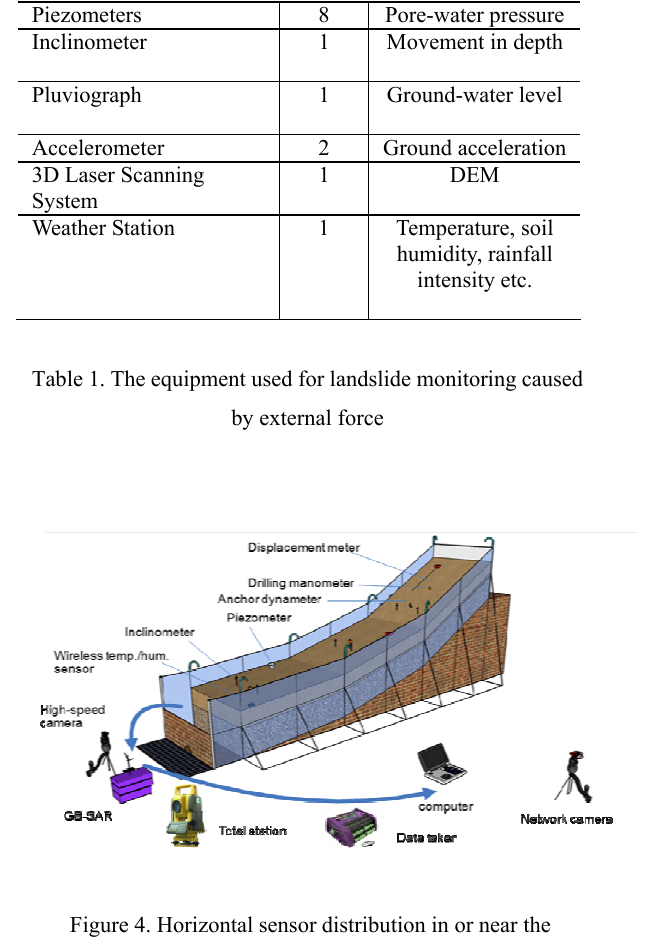
Figure 4. Horizontal sensor distribution in or near the landslide body